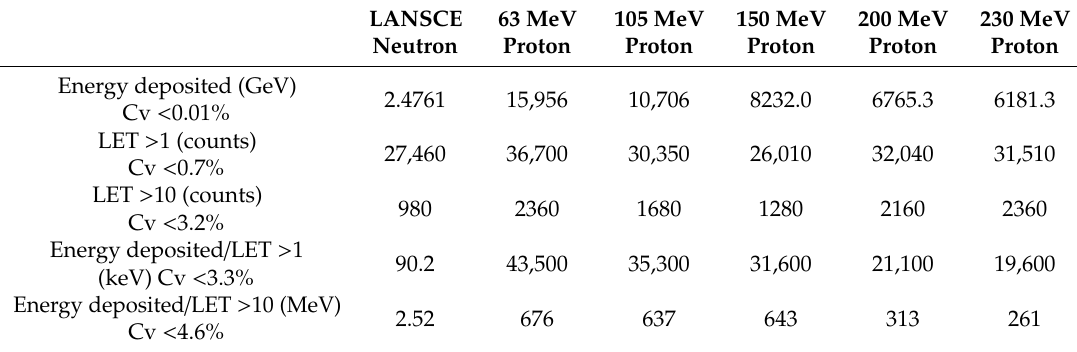
Energy deposition analysis results for the layer structure with SiGe for 10 10 neutron / proton